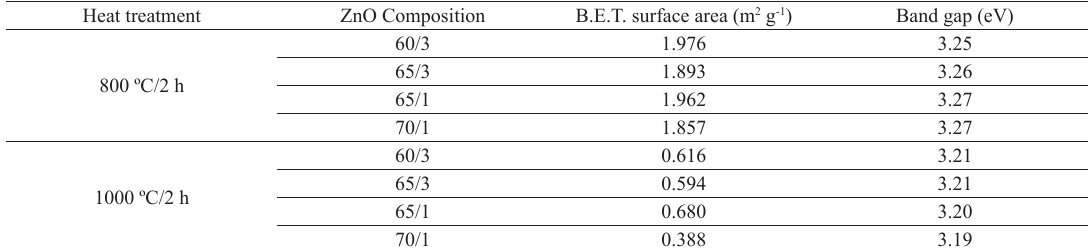
Table 3. Textural analysis (B.E.T. surface area) and band gap of 60/3, 65/1, 65/3, and 70/1 heat-treated ZnO compositions at 800 ºC/2 h and 1000 ºC/2 h. Heat treatment